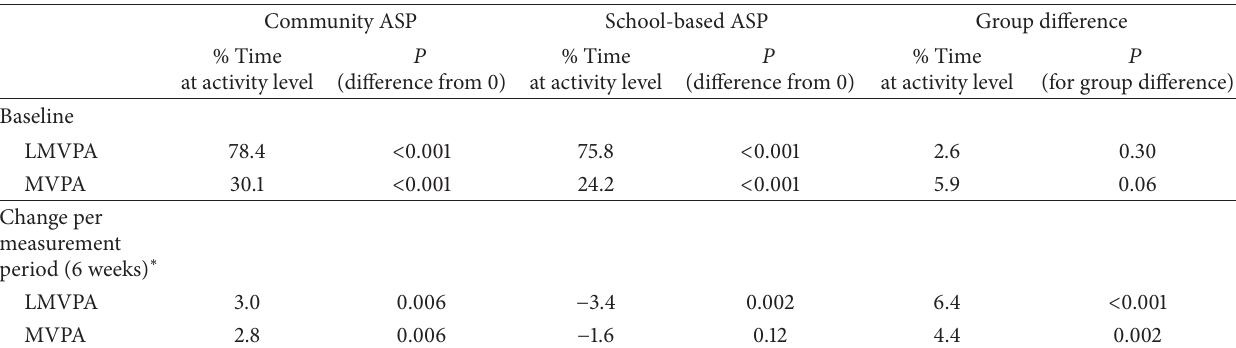
Table 3: Between-group comparison of time spent in physical activity (model-implied estimates). Community